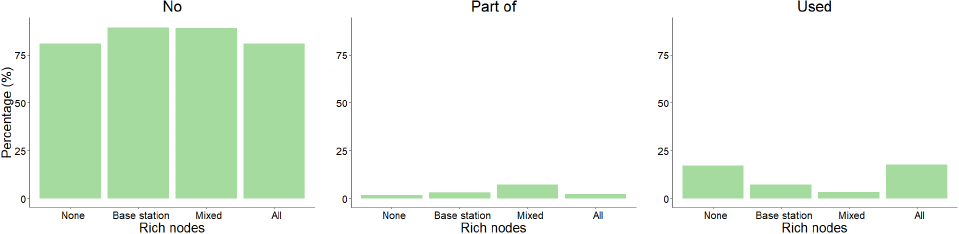
Figure 35. Deployment distribution between usage of rich nodes and usage of testbed facilities.